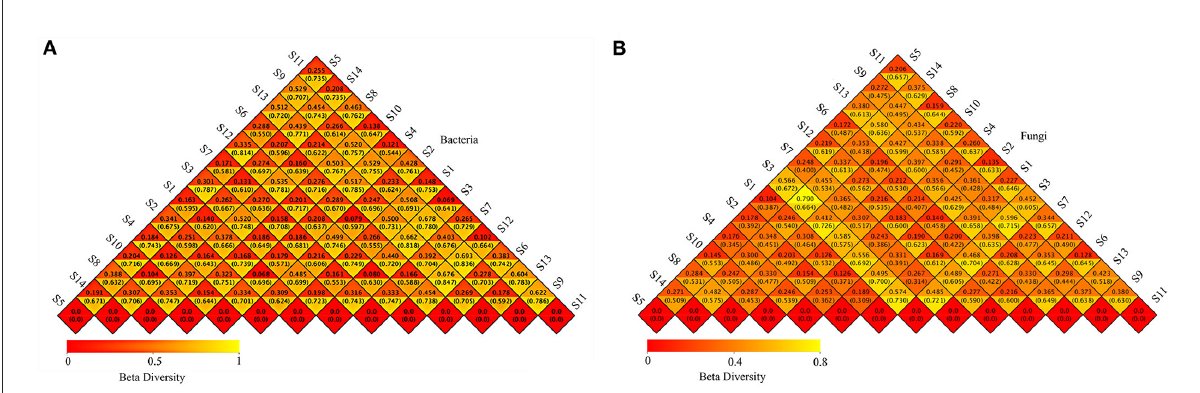
FIGURE3 Beta diversity of bacterial (A) and fungal (B) heat map based on the UniFrac distance. The upper triangle is the weighted distance. The distance from the lower triangles is the unweighted